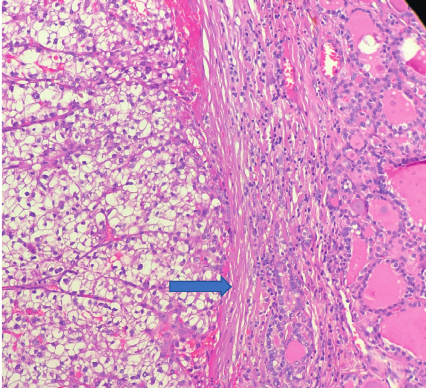
Figure 2: Hematoxylin-eosin staining showing large clear cells. A thin fibrovascular network is shown (arrow). Cells have an eo- sinophilic foamy vacuolated